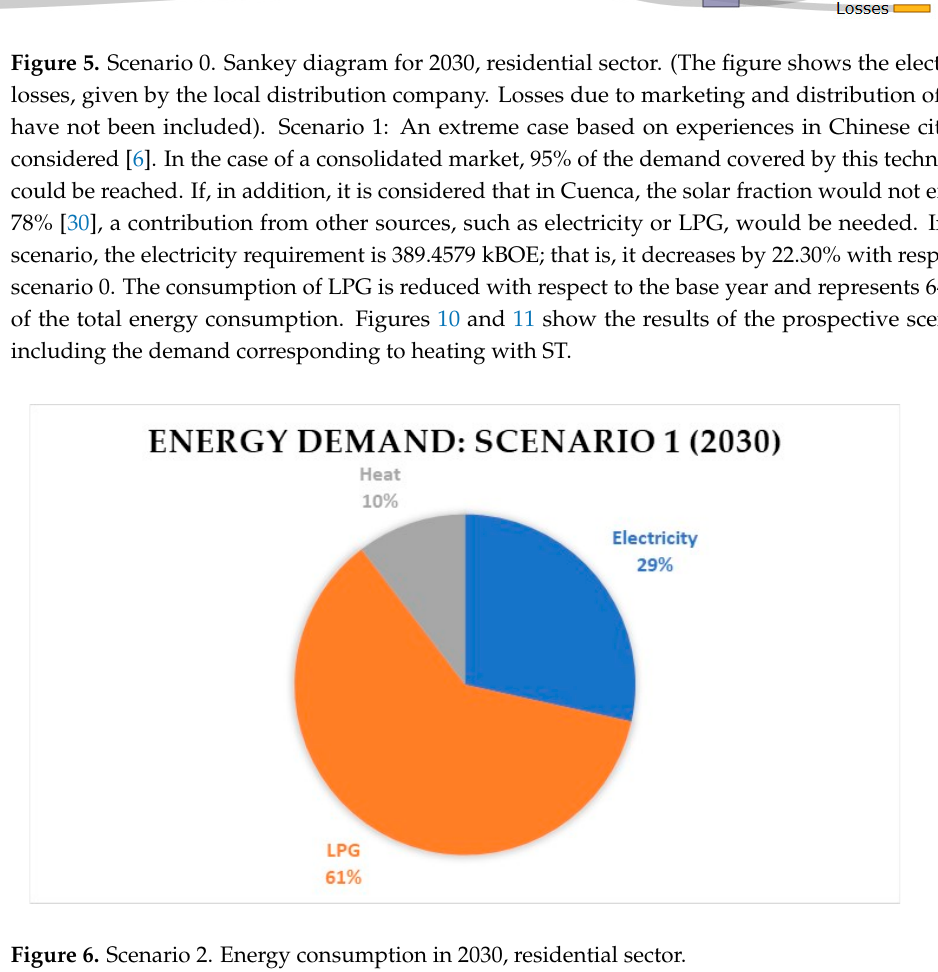
Figure 5. Scenario 0. Sankey diagram for 2030, residential sector. (The figure shows the electricity